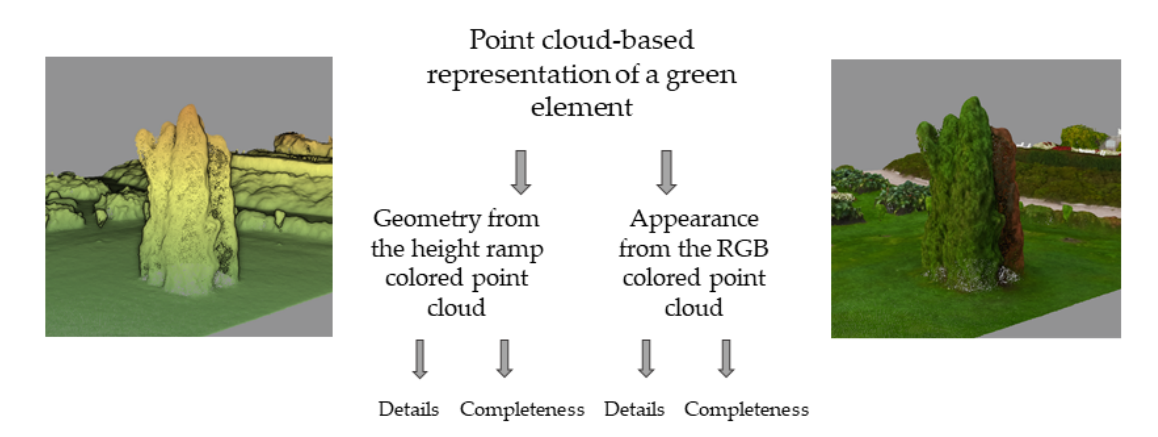
Figure 5. Parameters for the comparative analysis. The parameters of geometry were tested with height ramp colored point clouds and the parameters of appearance with RGB colored point clouds. Table 2. The criteria for the ability of the point cloud data to convey information on the tested parameters. Ability to Convey Information Rating Description No